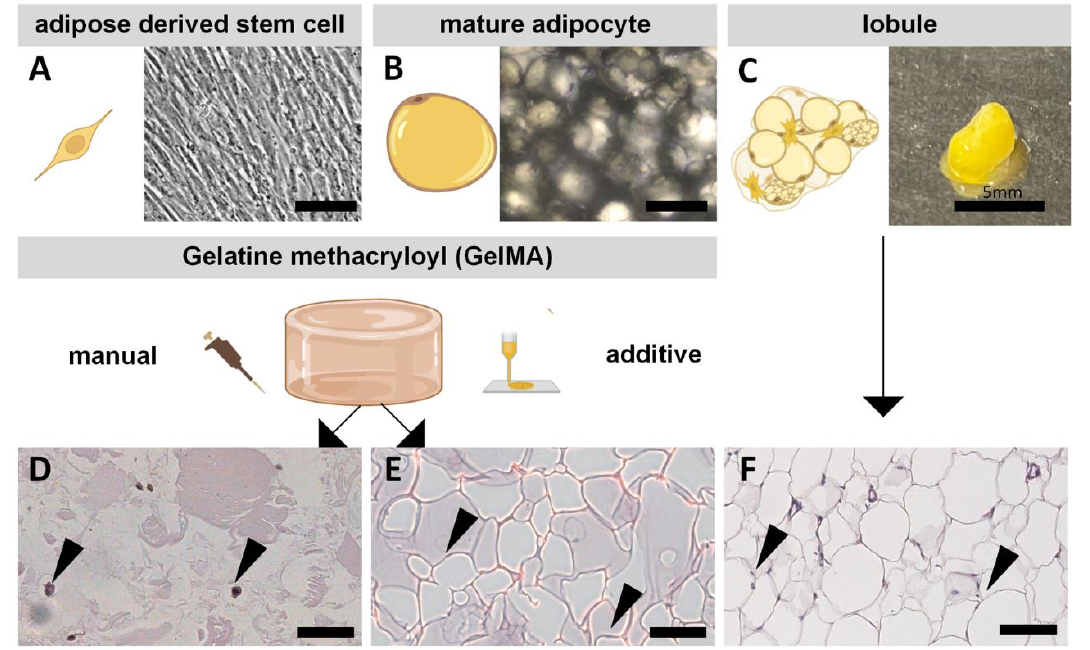
Figure 3. Overview of ASCs and adipocyte morphology in GelMA-based in vitro models and native adipose tissue: schematic illustration and light microscopic images of ( A ) ASCs on tissue culture polystyrene and ( B ) mature adipocytes in suspension culture. ( C ) schematic illustration of a lobule and macroscopic image. Hematoxylin-eosin staining of manually produced ASCs in GelMA on day 15 ( D ), mature adipocytes in GelMA on day 1 ( E ), and explanted lobule on day 1. ( F ) Hematoxylin stains all acidic structures in blue (cell nuclei, indicated by an arrow), eosin stains all alkaline structures in red (mainly GelMA and collagen), and accumulated lipids washed out, visible as white holes; scale bar 100 µm.